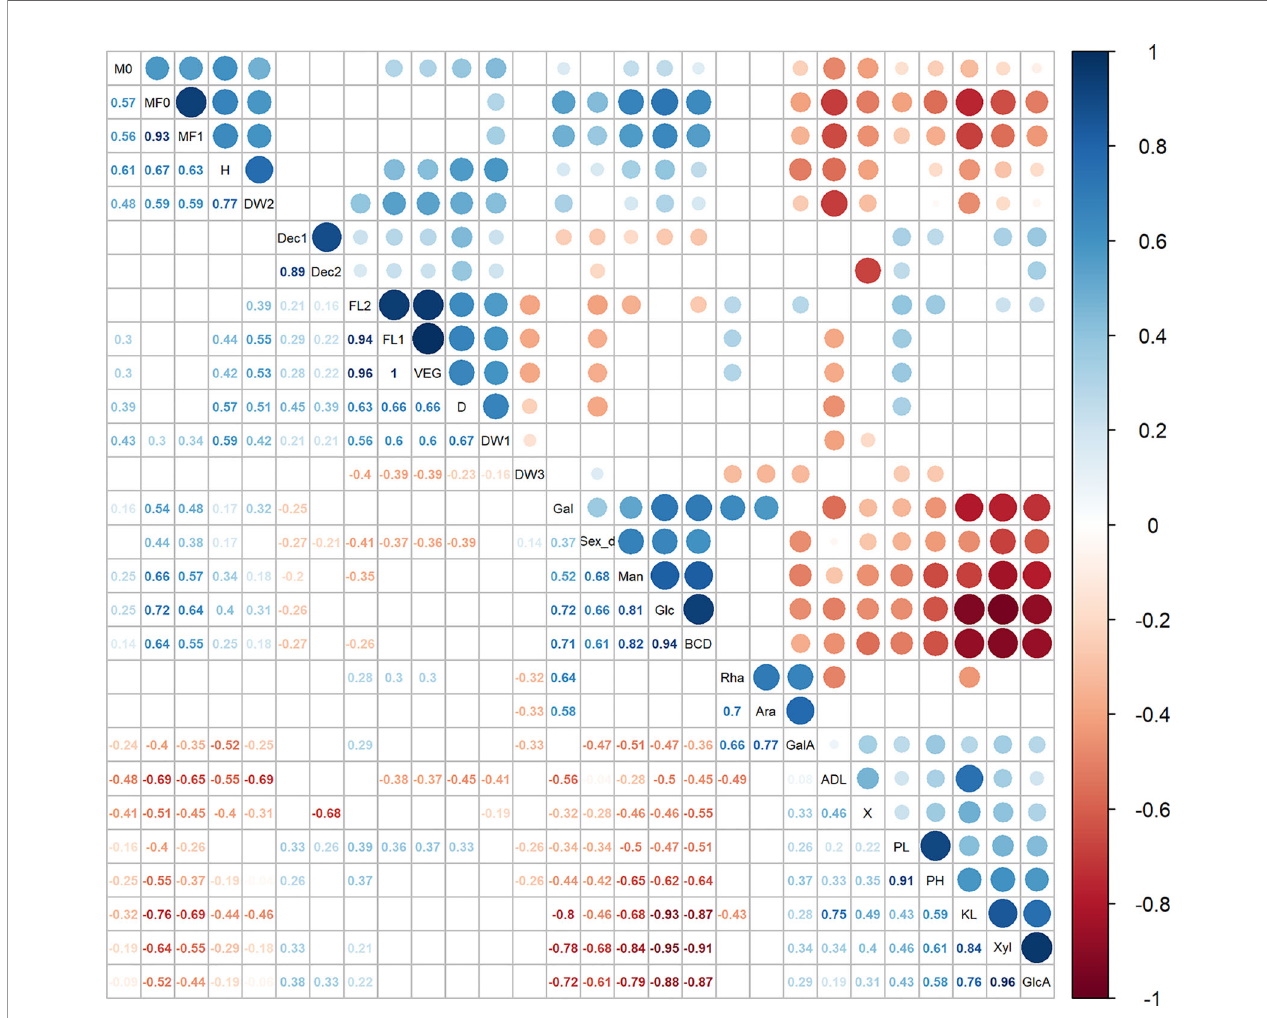
FIGURE 2 | Correlation analysis between 28 agronomic measurements, fl owering stages, fi ber traits, and cell wall components. Signi fi cant correlations were set at a con fi dence level of 0.95, and blank cells represent no signi fi cant correlations. Rha, Rha%dm; Ara, Ara%dm; Gal, Gal%dm; GalA, GalA%dm; Glc, Glc%dm; Man, Man%dm; Xyl, Xyl%dm; GlcA, GlcA%dm; KL, KL%dm; ADL, ADL%dm; FL1, FL_Begin; FL2, FL_Full; Sex_d, Sex determination; DW1, DW_S5(g); DW2, DW_S(%); DW3, DW(%); BCD, BCD%; X, ( c ); Dec1, h Dec_1; Dec2, h Dec_2. See Table 3 for